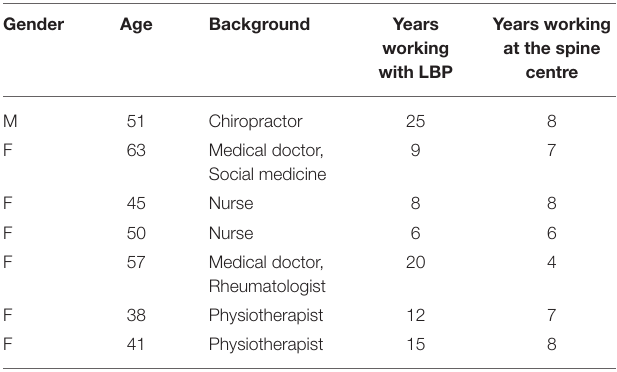
TABLE 2 | Healthcare staff in the ICF